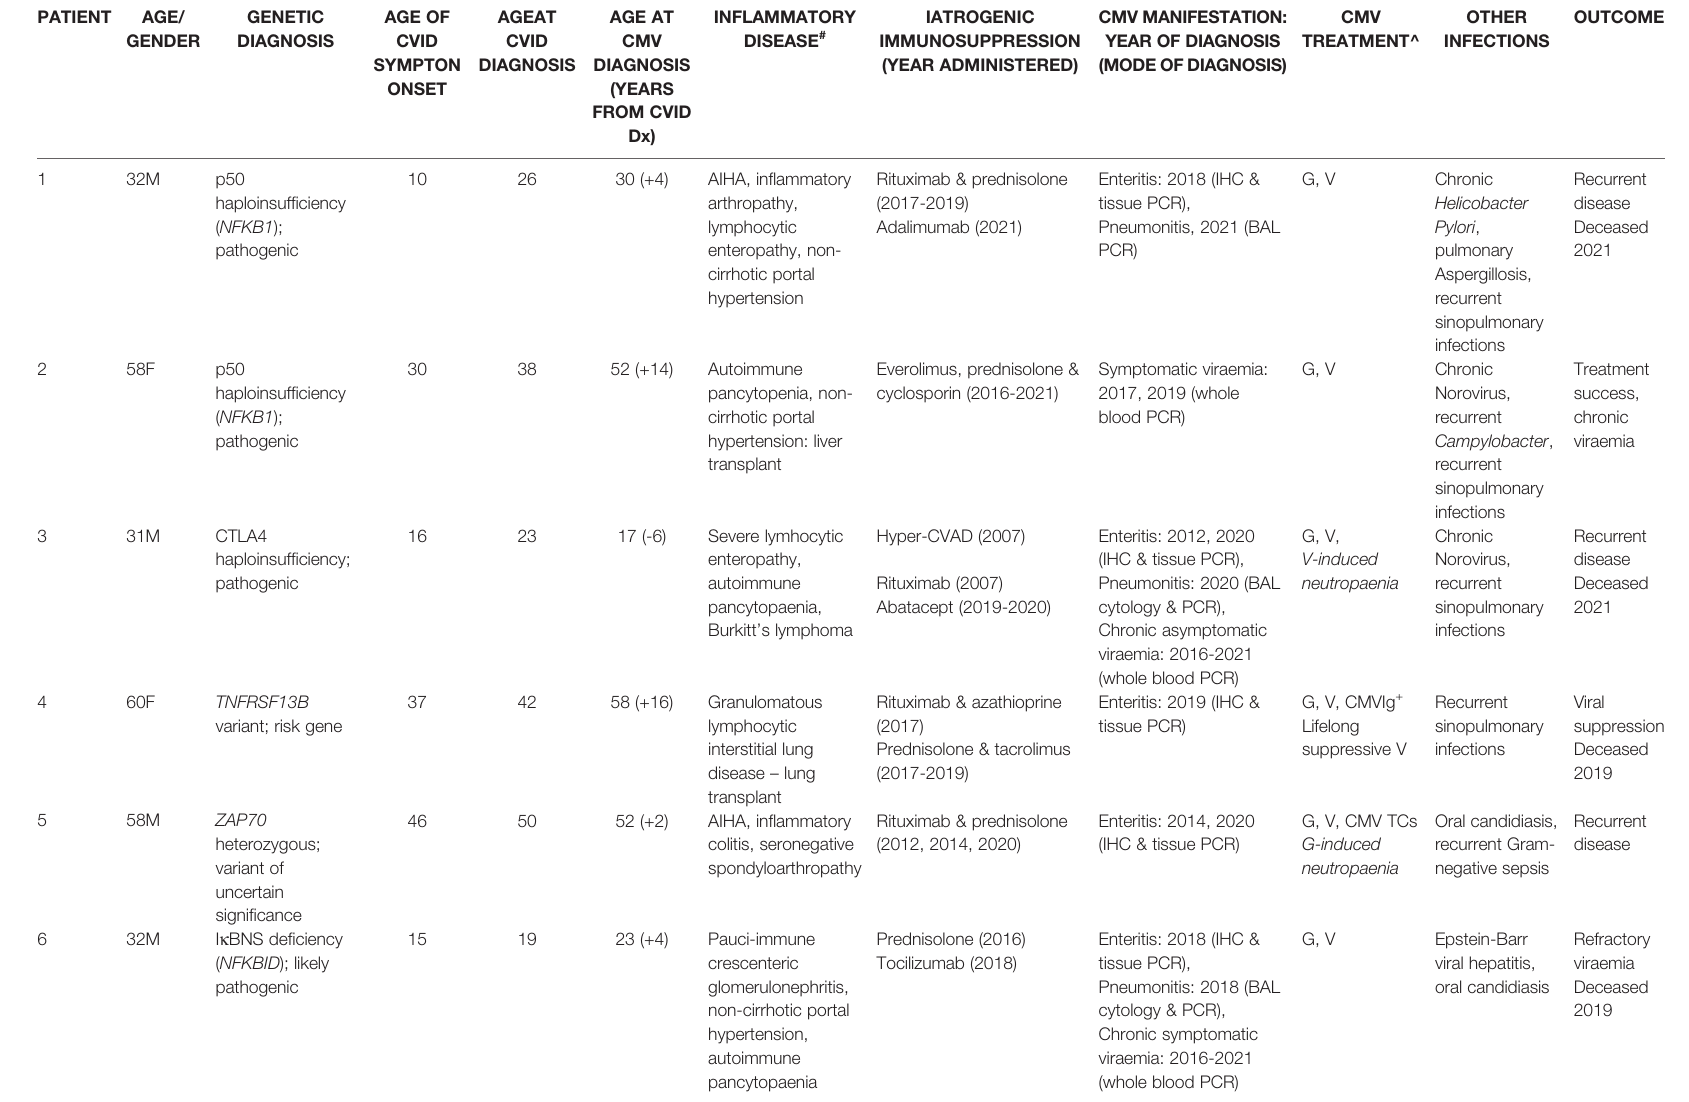
TABLE 1 | CVID + /CMV + cohort: clinical